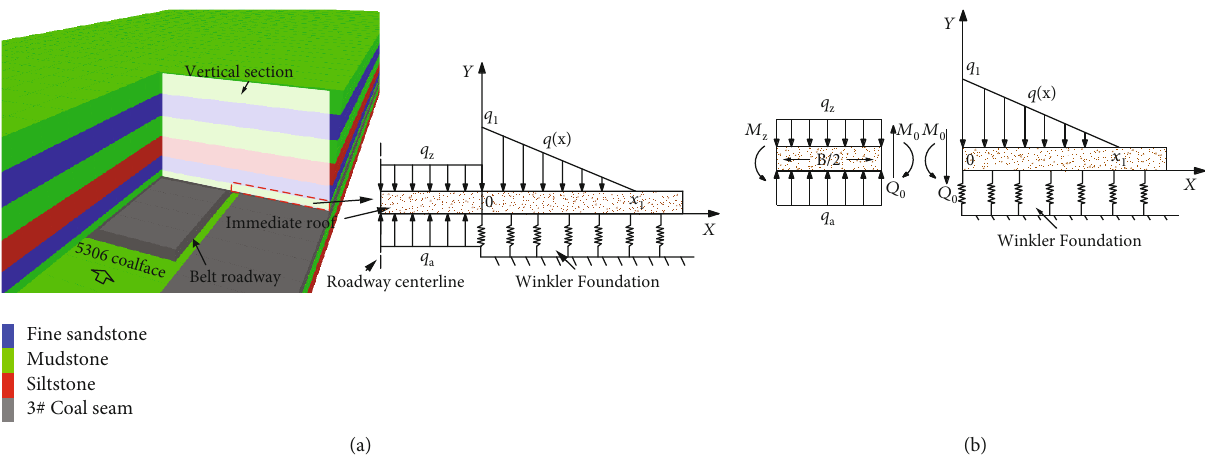
Figure 7: Cantilever beam model based on the Winkler foundation in the roadway roof: (a) mechanical model of the roadway roof; (b) analysis of the forces acting on the